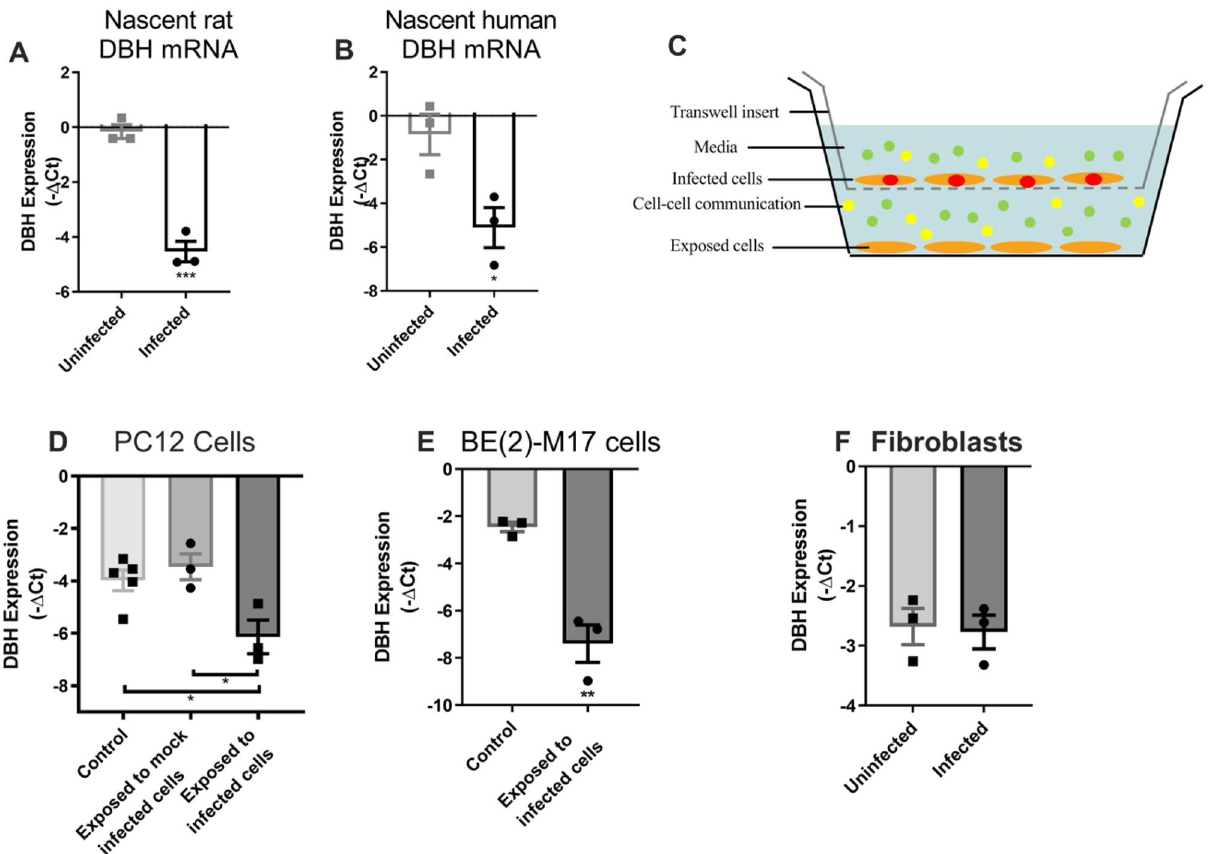
Figure 2. Noradrenergic cells infected with T. gondii secrete a signalling factor that transcriptionally regulates DBH. (A) Nascent DBH pre-mRNA transcription (relative to GAPDH) in catecholaminergic PC12 cells infected with pH-shocked parasites. After 5 days of infection nuclear run-on assays were performed. MOI 1; n = 3; *** p < 0.001. (B) Nascent DBH expression in uninfected and infected human neuronal cells as in (A). Multiplicity of infection (MOI) 1; n = 3, * p < 0.05. (C) Scheme of transwell culture system with cells and T. gondii on the top layer and uninfected noradrenergic cells on the bottom layer separated by a 0.4 μm membrane. Cells are orange, parasites red, signalling factors in vesicles (green) and soluble (yellow). (D) DBH expression measured using RT-qPCR (relative to GAPDH) in PC12 cells from the bottom layer with either uninfected control, T. gondii infected, or mock-infected cells in the upper transwell layer. Mock-infected cells were incubated with heat-killed T. gondii tachyzoites n = 3, * p < 0.05. One-way ANOVA p = 0.017, Tukey’s post hoc test uninfected and mock-infected vs infected p = 0.020 and p = 0.033, respectively. (E) Noradrenergic BE(2)-M17 cell expression of DBH mRNA cultured in transwells and treated as in ( C ); n = 3, p = 0.0038. (F) Infected fibroblasts in the upper layer of the transwell system. DBH expression levels were measured in exposed noradrenergic cells. DBH gene expression was not significantly altered in cells exposed to infected fibroblasts ( p = 0.84); ± SEM shown, n = 3, Student’s t